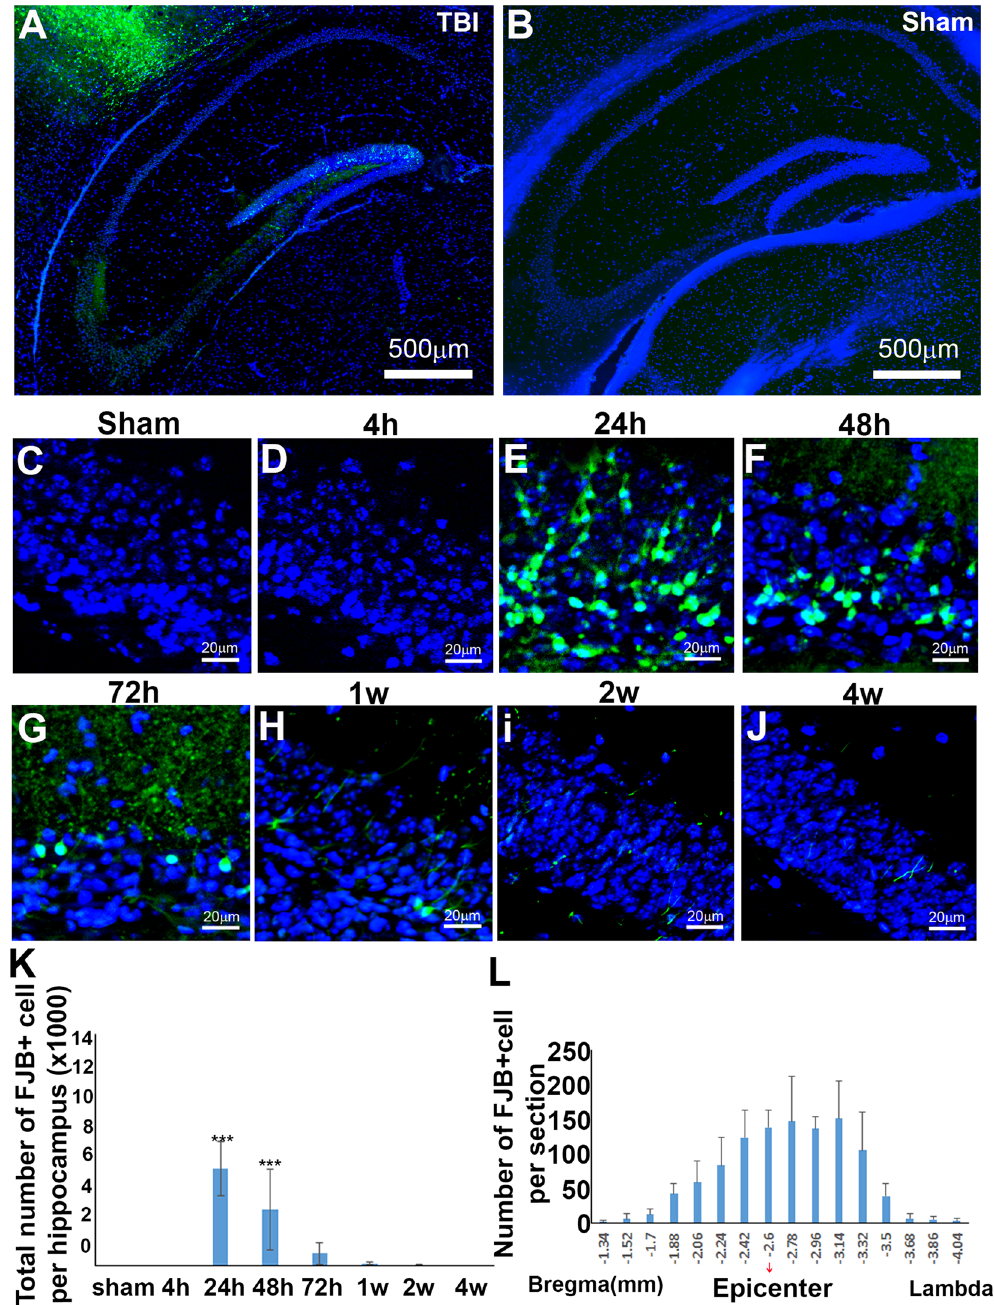
Figure 3. Temporal and spatial patterns of neuronal death in hippocampus after TBI. ( A ) Fluoro-Jade B staining (green) showed the neuronal death in hippocampus after injury. ( B ) Fluoro-Jade B the hippocampus of mouse received sham surgery. ( C – J ) The temporal pattern of neuronal death in hippocampus after sham surgery or injury. ( K ) Quantification of FJB stained cells in hippocampus (n = 4, *** p < 0.001) ( L ) The rostral- caudal distribution of FJB-positive cells in ipsilateral hippocampus at post-injury 24